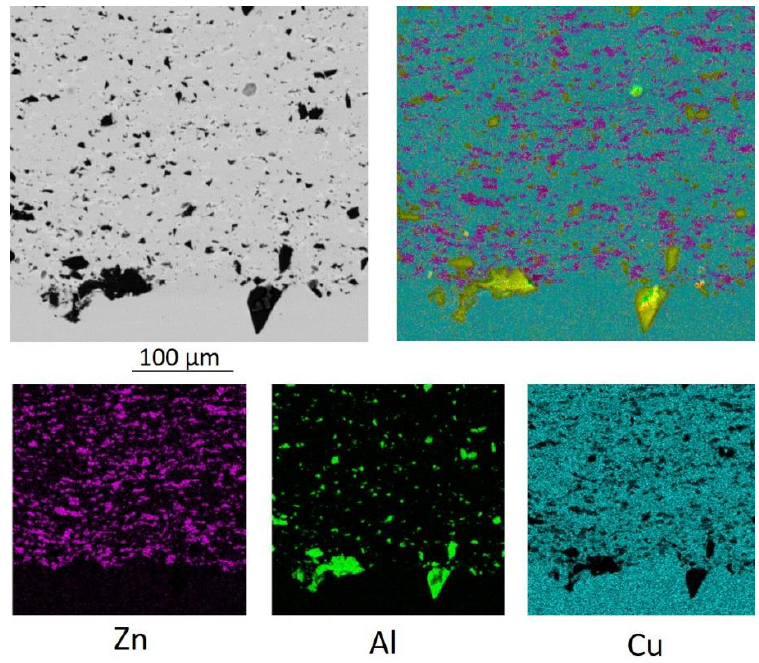
Figure 6. The microstructure and distribution maps of elements of the cold-sprayed Cu-60% Al 2 O 3 - 10% Zn powder blend with preprocessing stage.